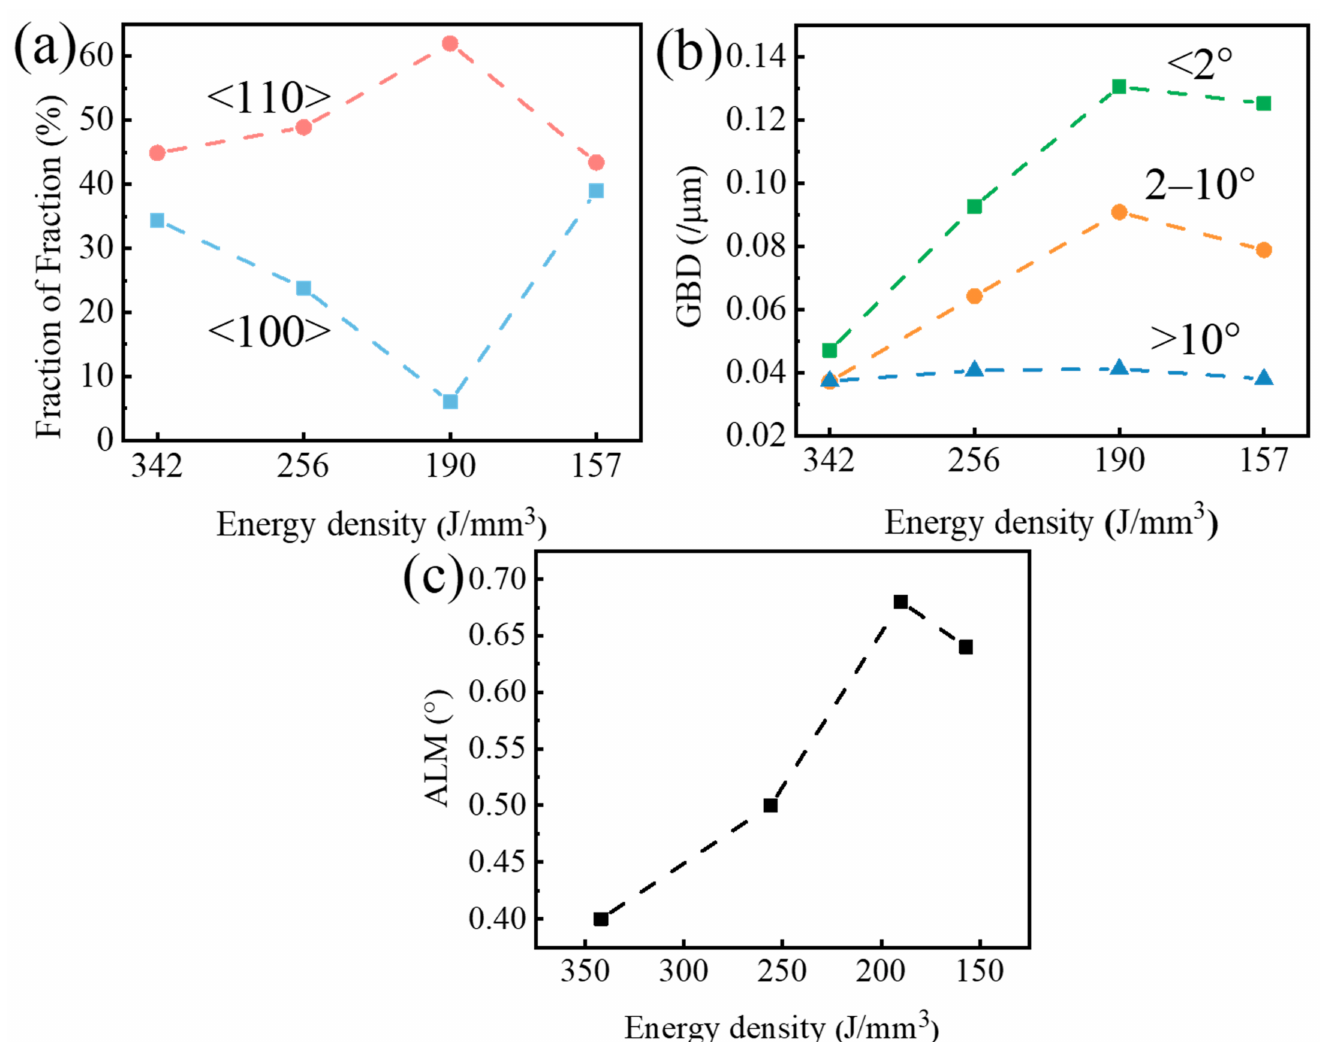
Figure 9. ( a ) Fraction of texture components, ( b ) Grain boundary densities, and ( c ) Average local misorientation of SLMed Ta made by different energy